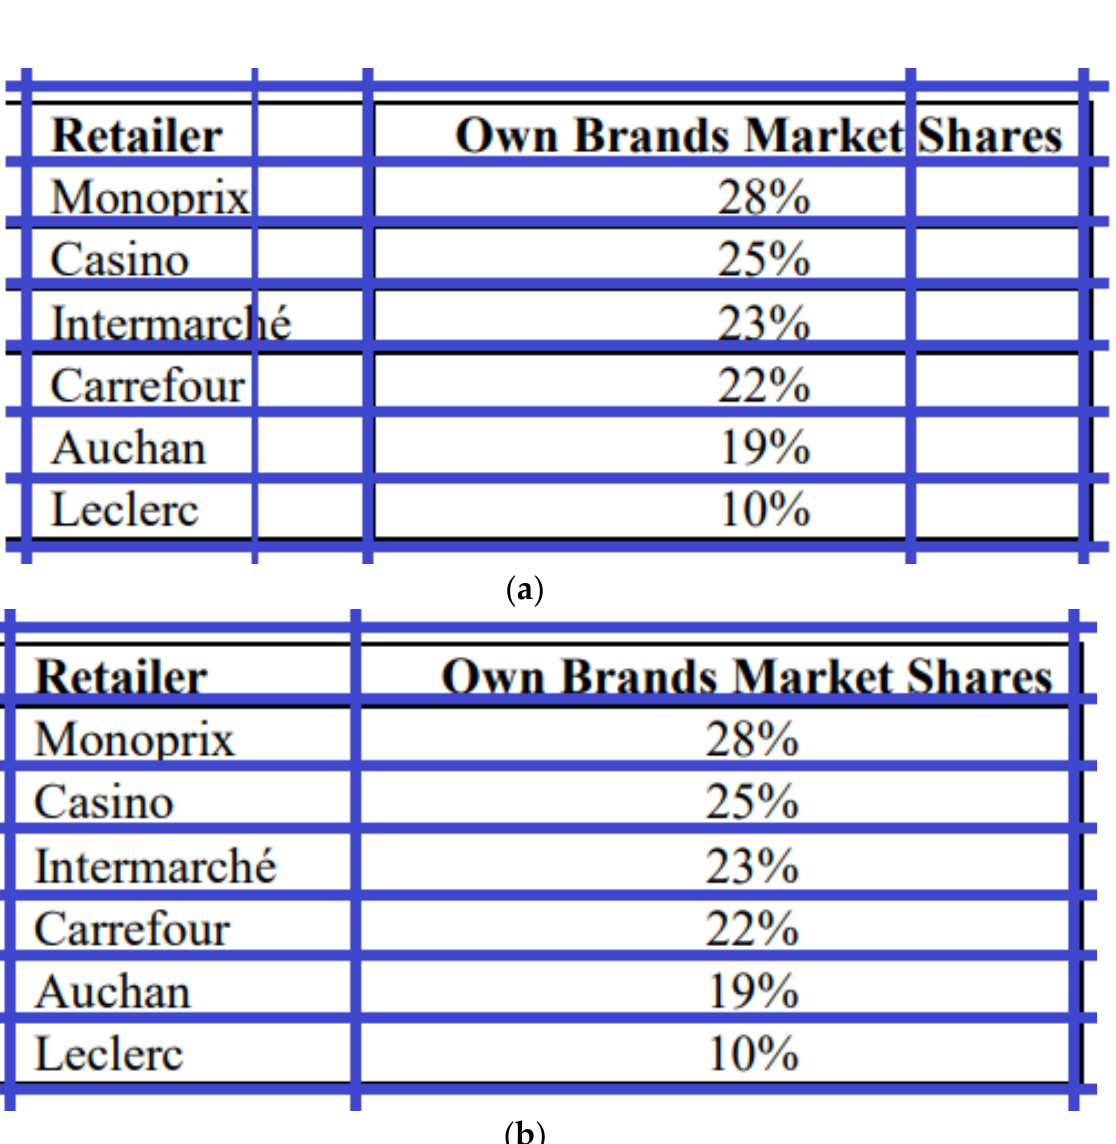
Figure 10. Comparison before and after adding SE module ( a ) without SE module; ( b ) with SE module.